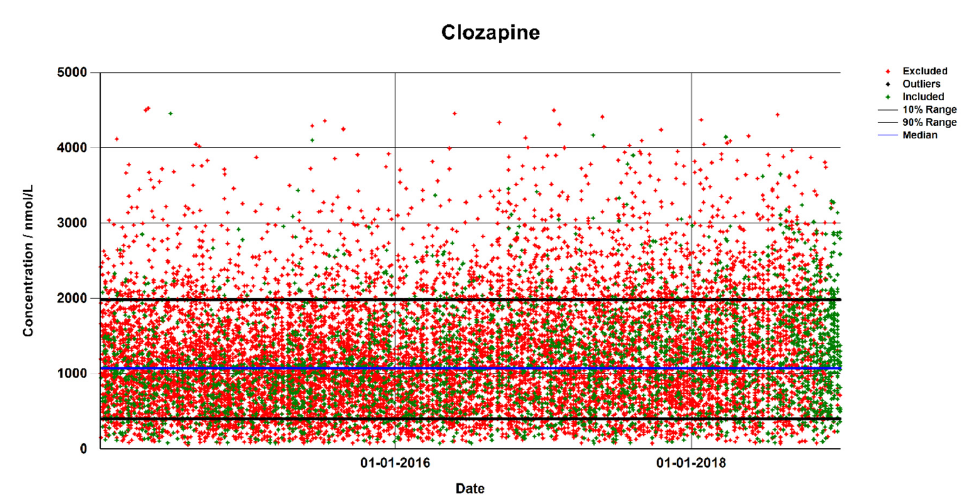
Figure 2. Plot of data points from the data set of clozapine from Aarhus University Hospital. Red dots are the sample results excluded and green are the samples included by the TDM model. The median is shown as a blue line, while the 10 and 90 percentiles are shown in black. The percentiles and median were calculated on the basis of the included samples only (included n = 3,224, excluded n = 10,871).